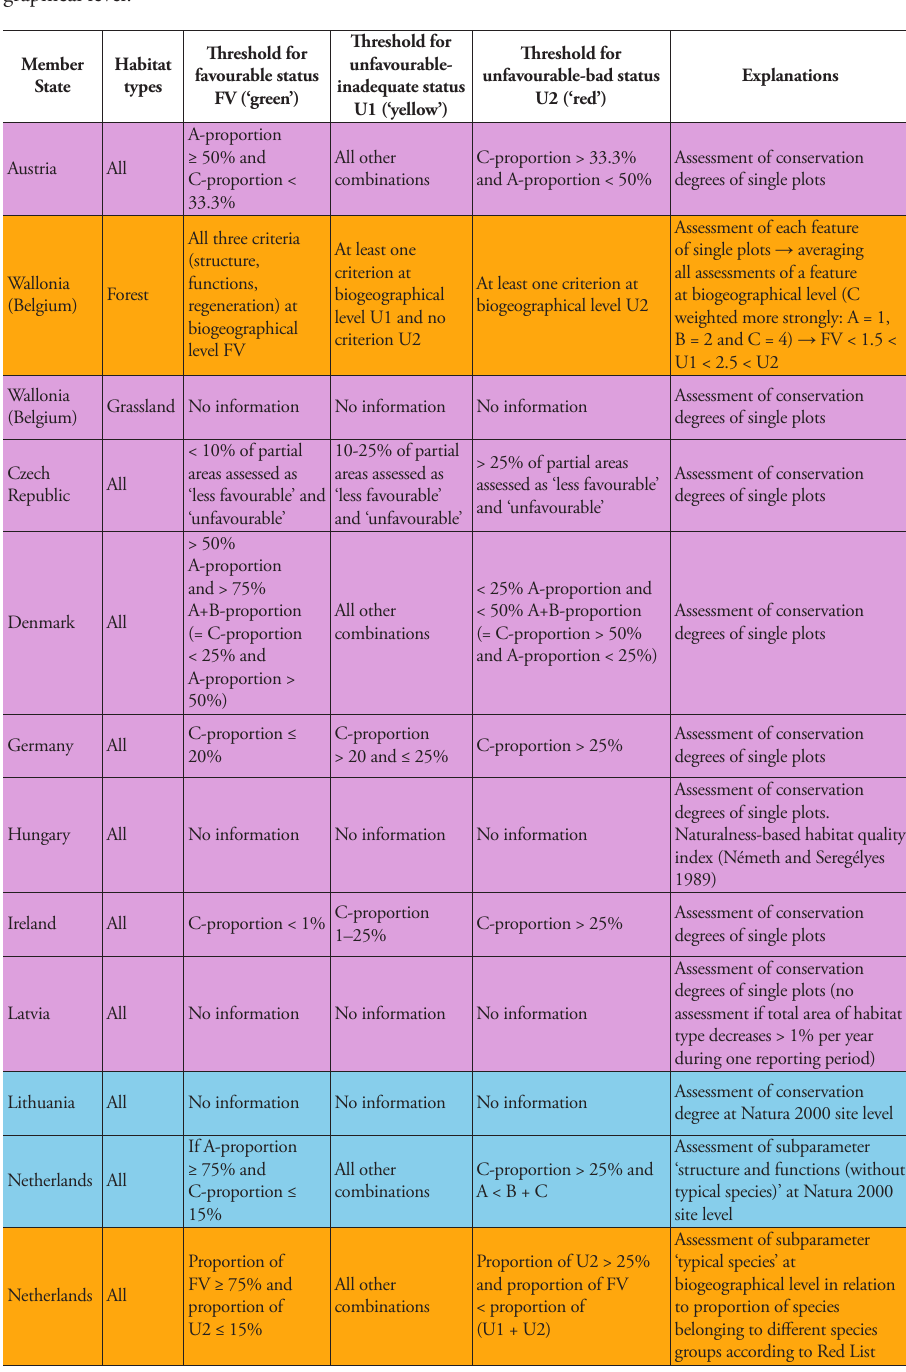
Table 2. Assessment of parameter ‘structure and functions’ in Member States – row colours: violet – as- sessment at single plot level, blue – assessment at Natura 2000 site level, orange – assessment at biogeo- graphical